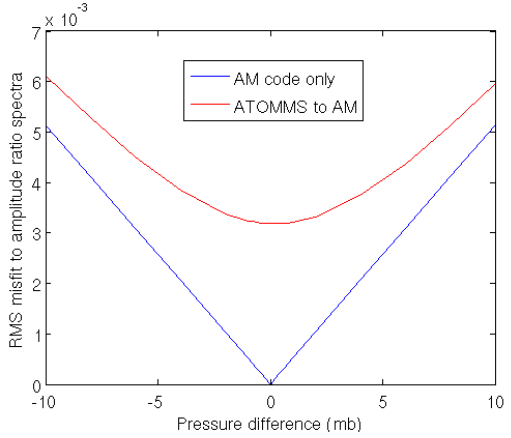
Fig. 5. Sensitivity of ATOMMS 183GHz spectra defined in Eq. (9) to variations in pressure. The blue line is the RMS difference be- tween the AM 6.2 model and itself as the pressure difference is varied. The red line is the difference between the ATOMMS spec- tra and the AM 6.2 model The minimum error occurs about 0.1mb above the measured surface pressure.